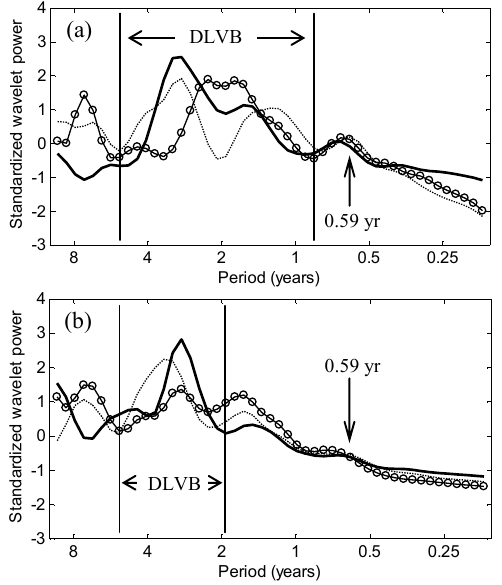
Fig. 3. (a) Coherent modes of temporal variability for the wavelet power spectrum of monthly runoff anomaly over the Pearl River basin. The bold line is the first mode, while the line with circles and the dashed line are the second mode and the third mode, respectively. DLVB stands for the dominant low-frequency variability band (0.83–5.21yr). (b) Same with (a) but for soil moisture with DLVB